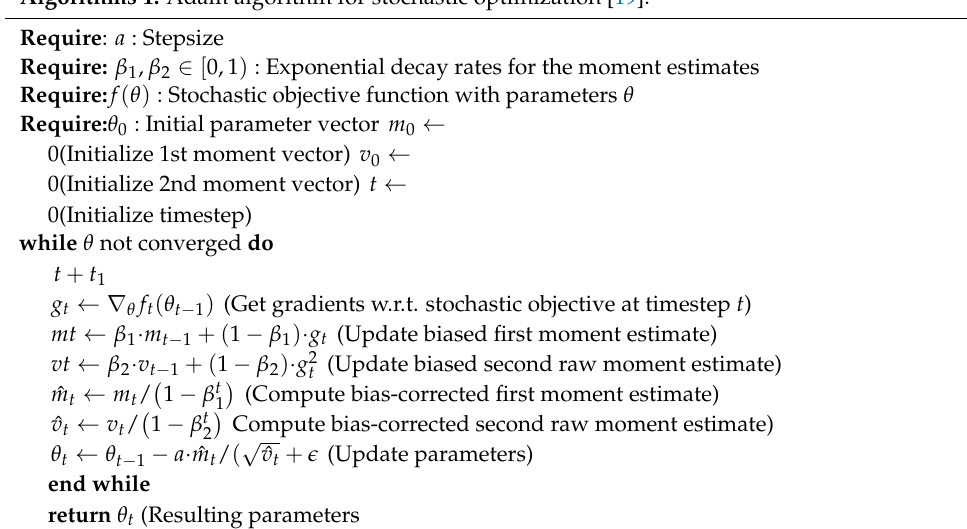
Figure 9. Adam algorithm for stochastic optimization [19].